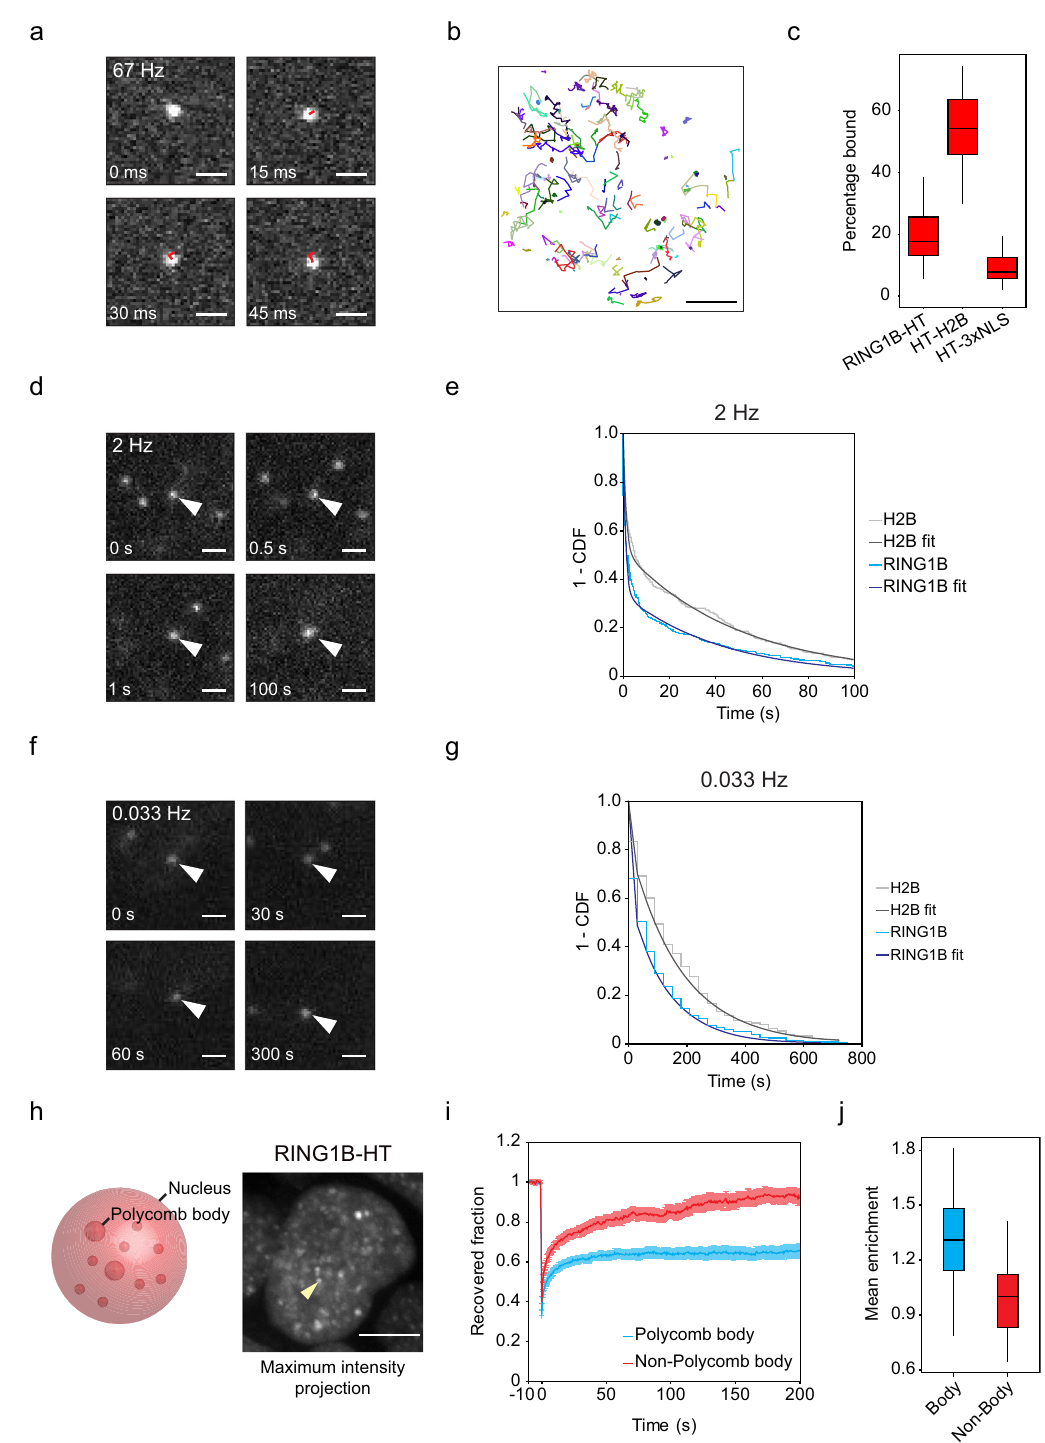
multiple molecules overlapping and being con fl ated in our ana- lysis. Using this approach, the distribution of track lengths for chromatin-bound RING1B molecules fi t well to a biexponential decay modelling short and long-lived binding events (Fig. 2e). The mean survival times obtained from this model are in fl uenced by photobleaching. Therefore we used H2B-HaloTag, which binds stably to chromatin on the order of hours 71 , as a control to correct for the in fl uence of photobleaching 72 – 75 . However, we were still unable to accurately estimate the duration of long binding events as the observed dwell times for RING1B